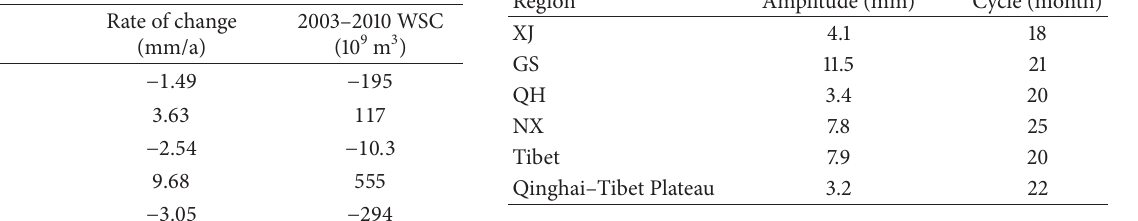
Table 1: Amount of WSC over northwestern China from 2003 to 2010.